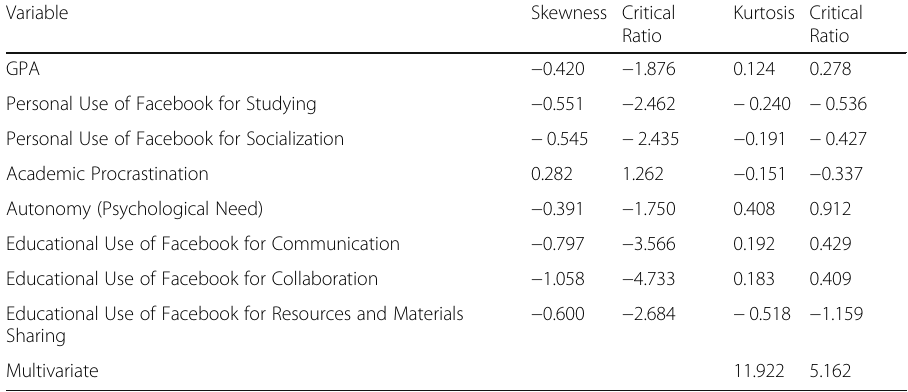
Kurtosis Critical Ratio Ratio